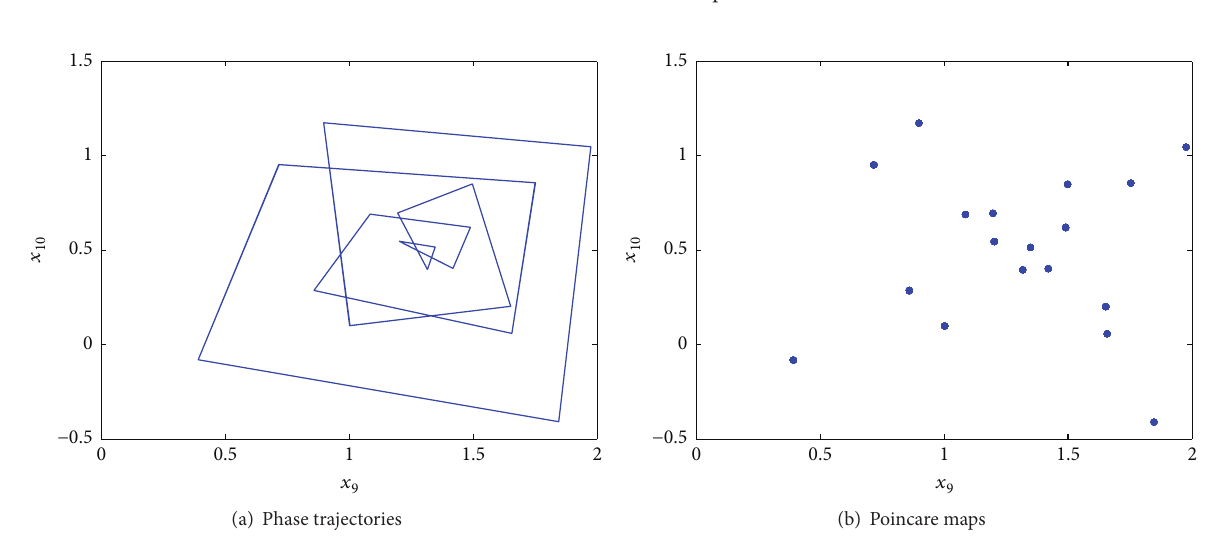
Figure 6: 𝜔 = 180 without random